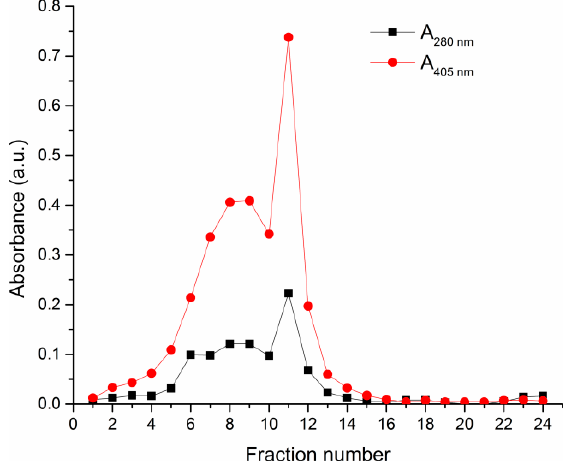
Figure 1. Elution profile of commercial HRP preparation from the CMC chromatographic column. Elution system: equilibration buffer—5 mM sodium acetate buffer (pH 4.6), elution buffers—15 mM and 50 mM sodium acetate buffers (pH 4.6) and 100 mM sodium acetate buffer (pH 5.5).